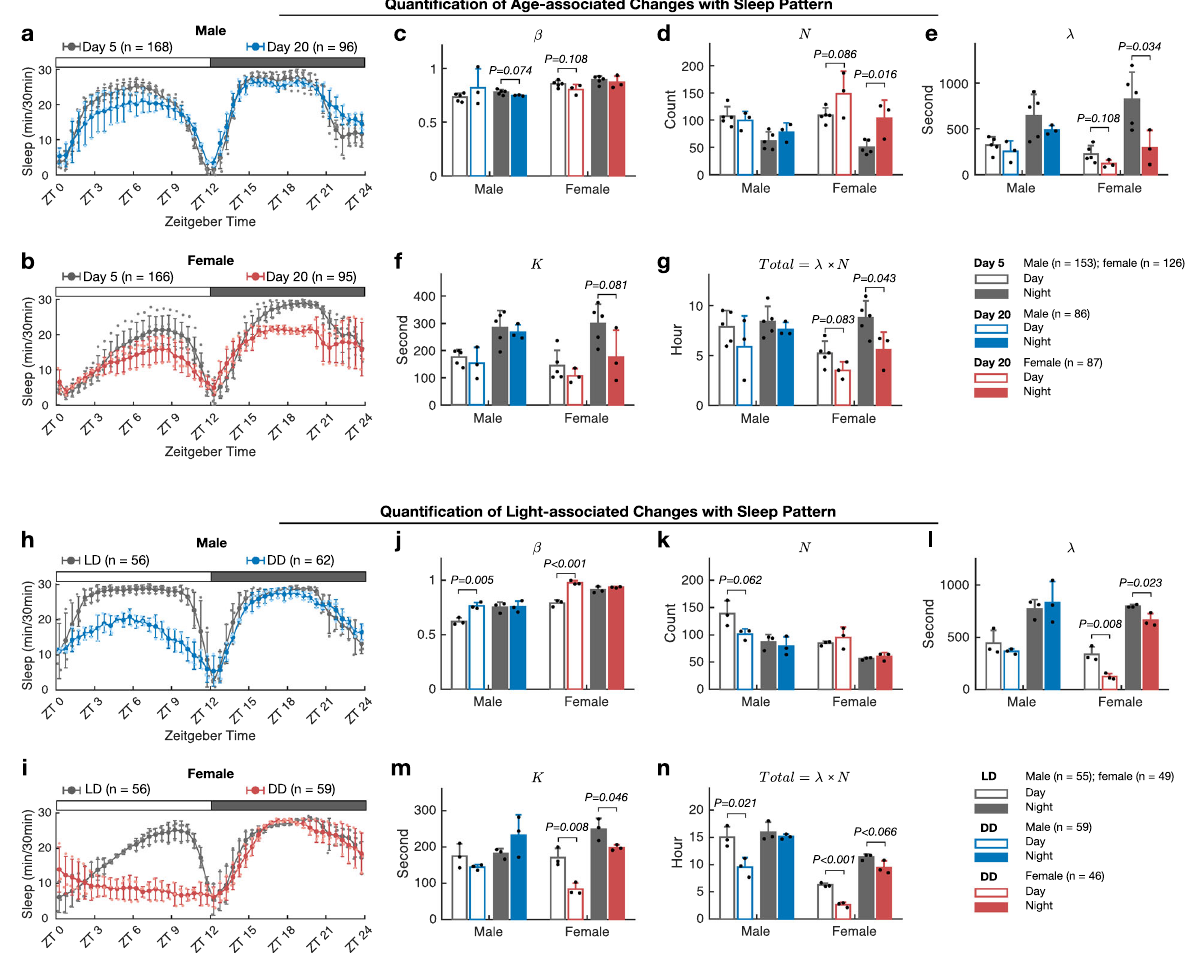
Fig. 4 Sleep pattern changes in older fl ies or under constant darkness. a – b Sleep pro fi les of older male and female fl ies (20 days post eclosion) compared with younger fl ies (5 days post eclosion). The blue, older male; red, older female; grey, younger male or younger female. Error bar indicates SEM of fi ve biologically independent experiments for the younger groups and three biologically independent experiments for the older groups. c – g Comparison of the sleep pattern parameters of older fl ies with the younger ones. The hollow and fi lled columns represent the mean of the parameter in the light and dark phases, respectively; grey: younger fl ies; blue, older male; red, older female. h – i Sleep pro fi les of fl ies under constant dark condition (DD, 12 h:12 h) compared with groups under cyclic light condition (LD, 12 h:12 h). The blue, male in DD; red, female in DD; grey, male or female in LD. Error bar indicates SEM of three biologically independent experiments for the LD groups and three biologically independent experiments for the DD groups. The light phase of DD in h and i is hypothetically assigned in accordance with the normal light-dark condition (LD, 12 h:12 h). The fl ies in the DD group had been raised under the LD condition and then transferred to the DD condition. j – n Comparison of the sleep pattern parameters of fl ies under different light conditions. Grey: male or female in LD; blue, male in DD; red, female in